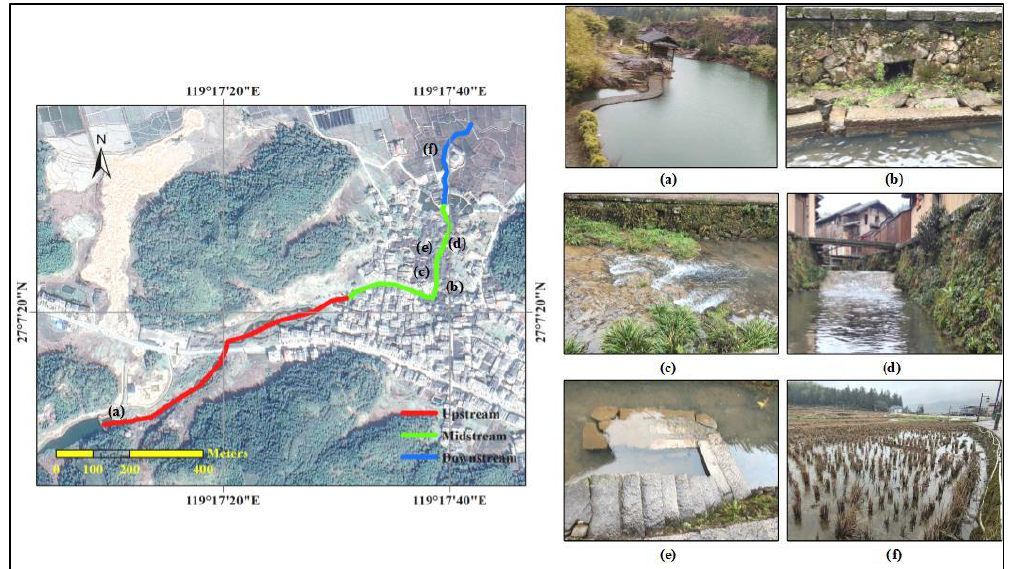
Figure 2. Ecological engineering facilities along the Carp Brook. The sketched map of the Carp Brook is indicated in bold lines: the upstream (red), the midstream (green), and the downstream (blue). Typical facilities are: ( a ) dam, ( b ) bank with caves, ( c ) weeds, ( d ) dam, ( e ) L-shaped sewer, and ( f ) farmland.